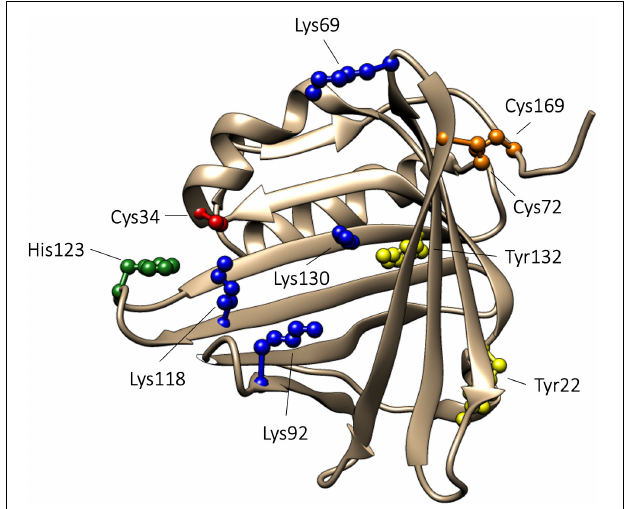
FIGURE 1 | 3D-structure of A1M. The 3D-structure of A1M is based on the published crystal structure (Meining and Skerra, 2012). Functionally important amino acids are highlighted: C34, described to be important for reduction, radical scavenging, and heme binding, is marked with red. Lysine residues (K69, K92, K118, and K130), described to be related to the yellow-brown modifications, are marked with blue. H123, suggested to take part in coordination of heme-iron, is marked with green. Tyrosine residues (Y22 and Y132), shown to be modified in radical scavenging reactions, are marked in yellow. The disulfide bridge, formed between C72 and C169, is marked in